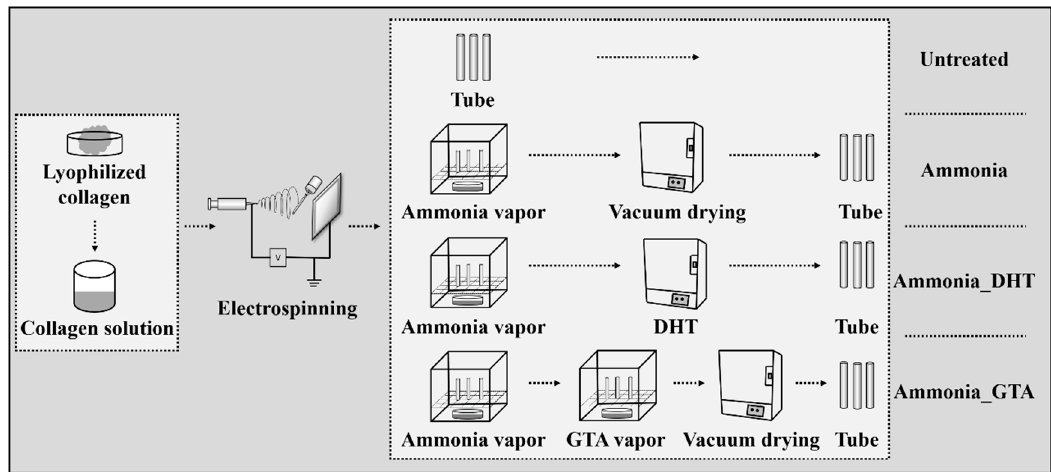
Figure 1. A schematic image of the preparation of collagen tube and various treatments were applied .